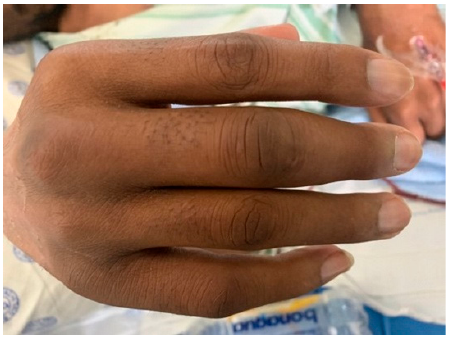
Figure 4. Patient’s right hand on admission, showing joint and finger swelling.